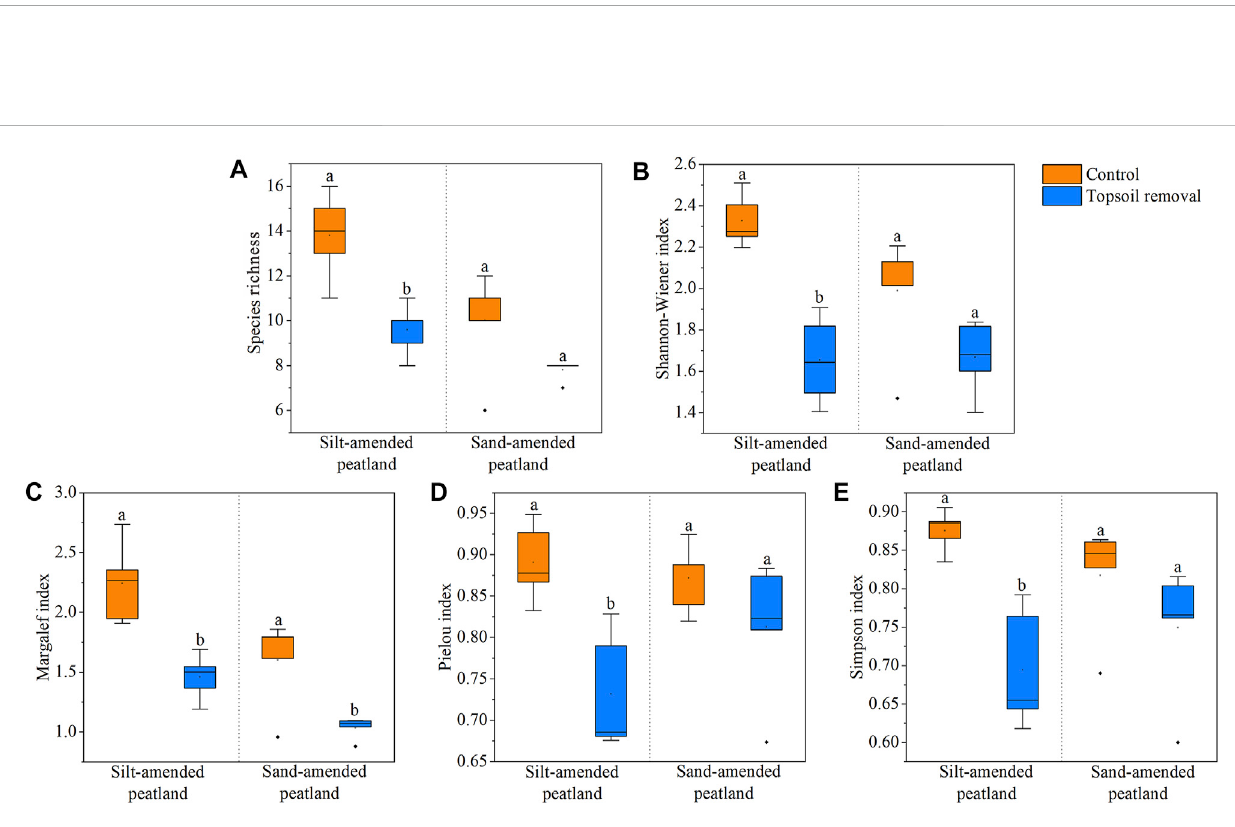
FIGURE 3 Species richness (A) , Shannon – Wiener Index (B) , Margalef Index (C) , Pielou Index (D) , and Simpson Index (E) in the silt-amended and sand-amended peatlands. Different lowercase letters indicate signi fi cant differences between the two treatment plots within the same peatland site ( p <